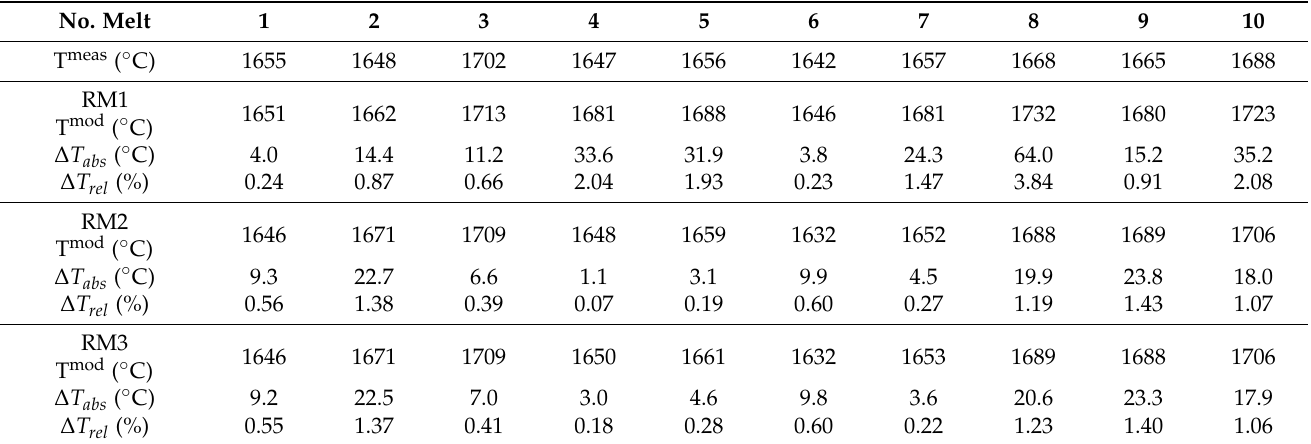
Table 1. The results of the three regression models.